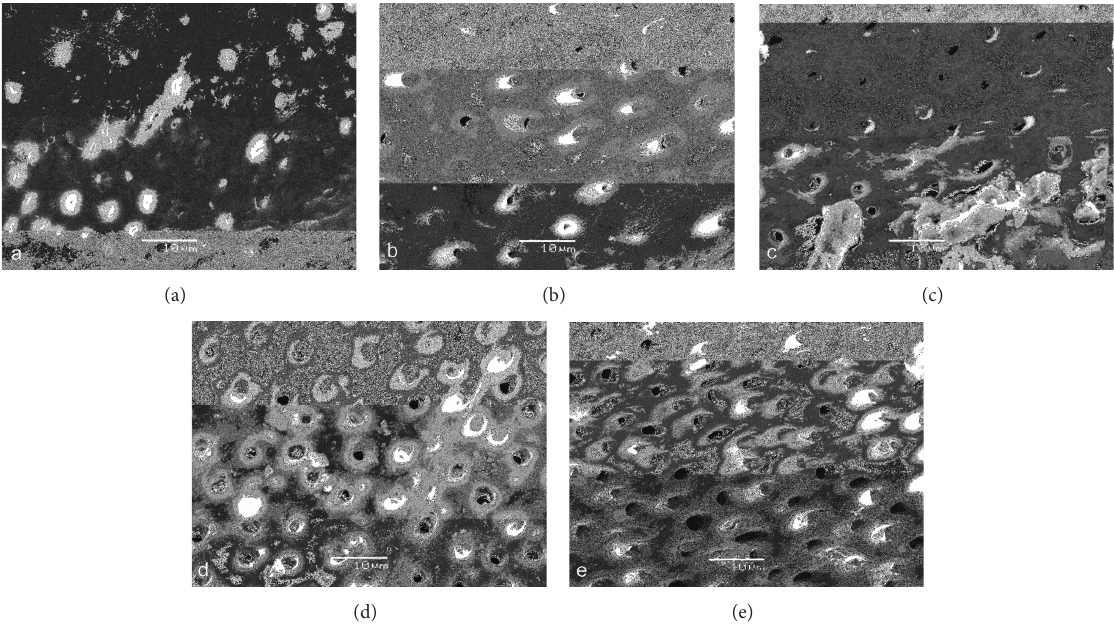
Figure 5: Photomicrographs of root canal wall in each group after final cleaning protocols (original magnification: 2000x; scalebar is 10 𝜇 m). Images (a)–(e) show canal walls at 1, 3, 6, 8, and 12 mm from the apex. In groups 4 and 9, open tubules and removal of smear layer were clearly observed at all sites except at 1mm. White areas of erosion around the dentinal tubule openings were seen. (a) is at 1mm from the apex and (e) is at 12 mm from the